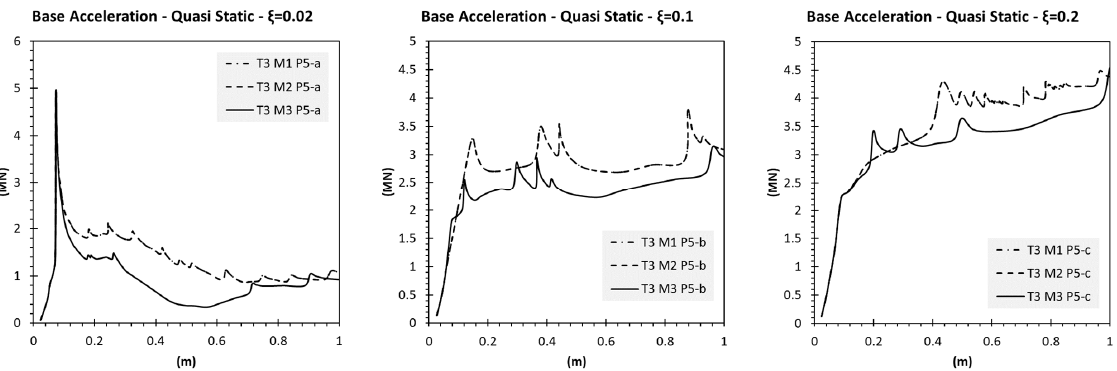
Figure 9. Role of damping in the quasi-static pushover curves, from left to right the damping ratio increases from 0.02, 0.1 and 0.2.